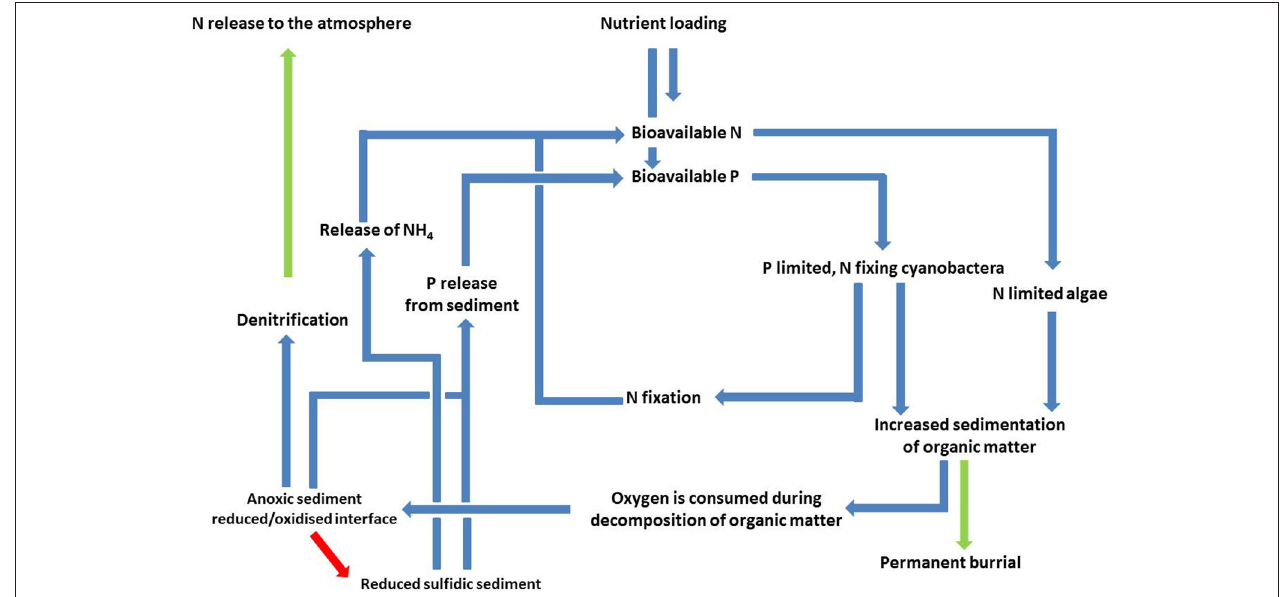
FIGURE 4 | A modified version of the vicious cycle presented in Tamminen and Andersen (2007) and Vahtera et al. (2007a) where the possible termination of denitrification has been added (red arrow). This takes place when the amount of organic matter is large enough to reduce both the sediment and bottom water, leading to a stop in the oxidation of ammonium (nitrification), which is a prerequisite for denitrificaiton to take place; however, denitrification higher in the water column may to some extent compensate for this (Dalsgaard et al., 2013). Both the quantity and quality (e.g., plankton community composition) of the spring bloom biomass may affect the magnitude of the nutrient sinks (green